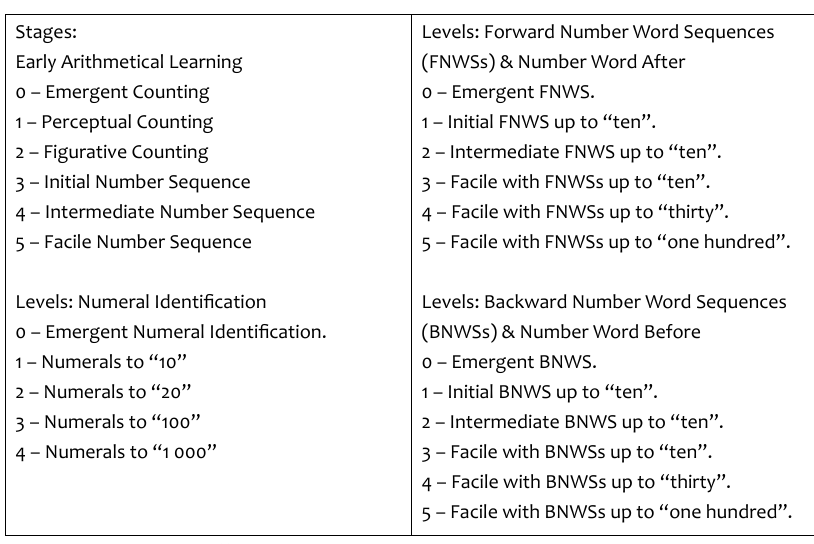
Table 2: The Learning Framework in Number.